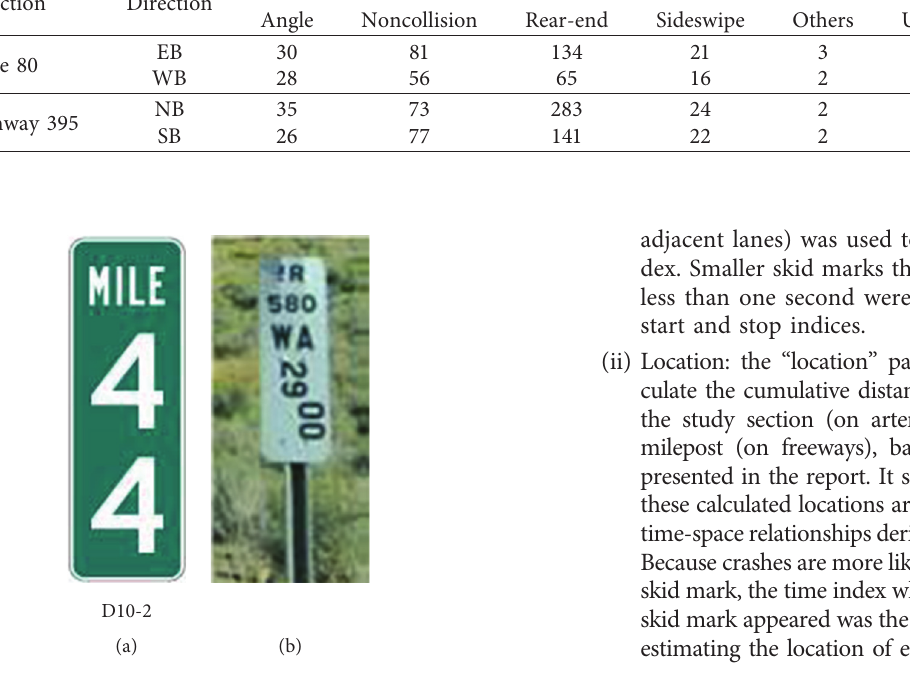
Figure 2: Milepost panels found along freeway study